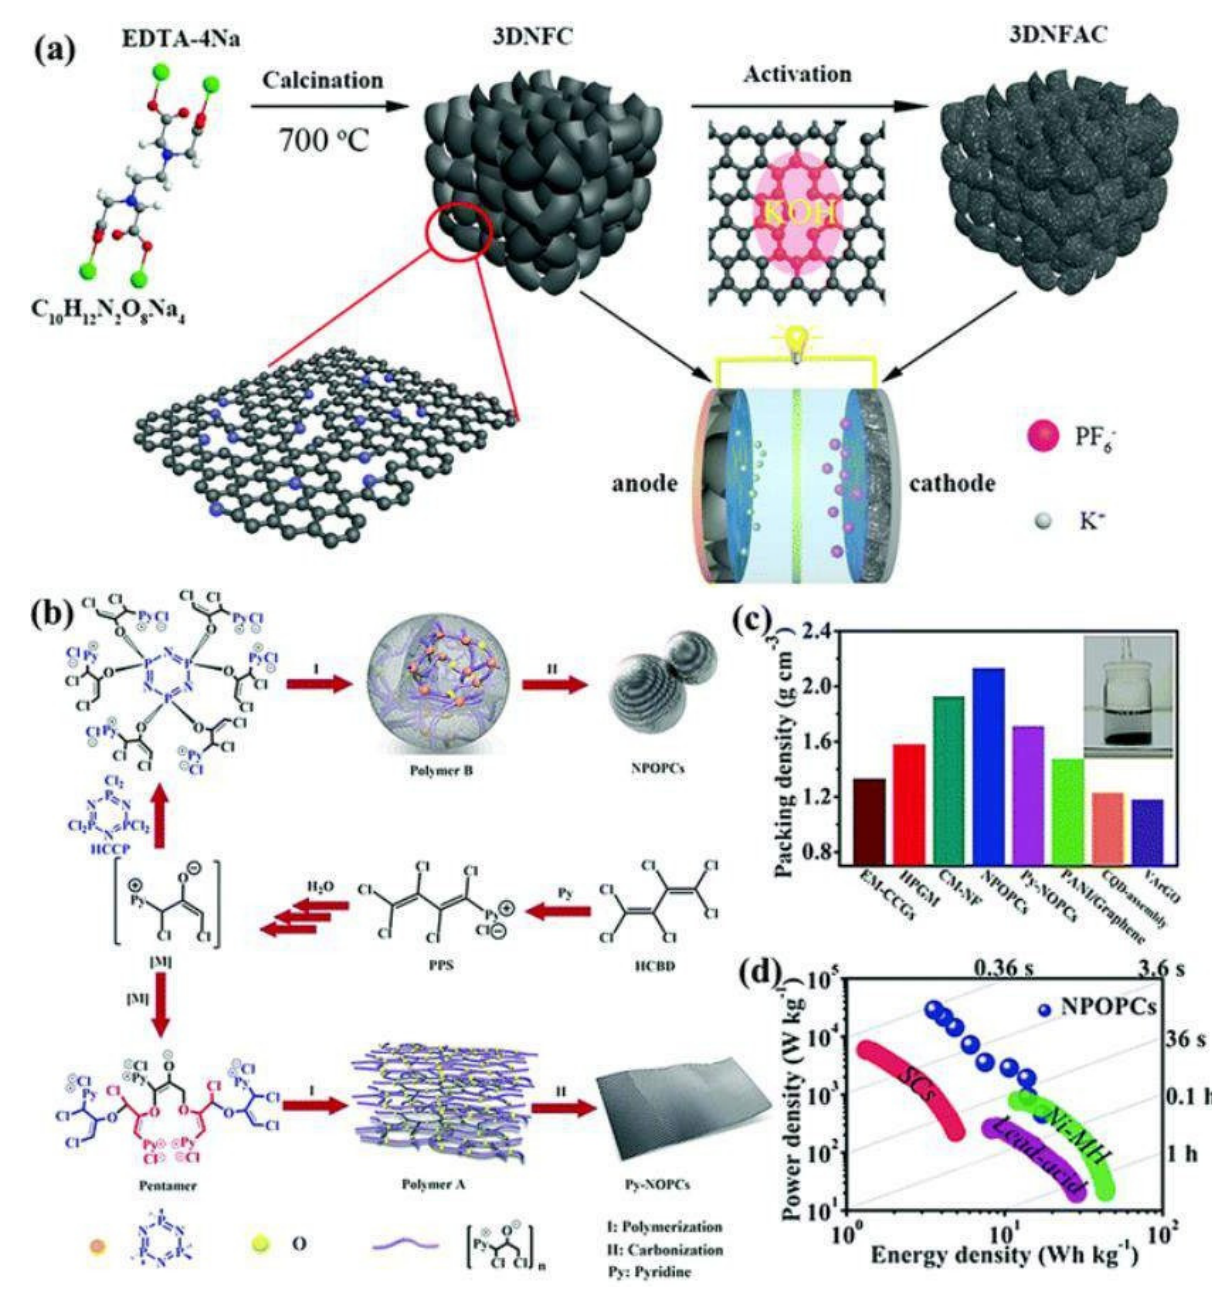
Figure 9. N-rich 3D hierarchical porous carbons shown schematically ( a ); the creation of porous carbons doped with several heteroatoms ( b ); packing rigor ( c ); Ragone plots ( d ). Reproduced with permission from [78].